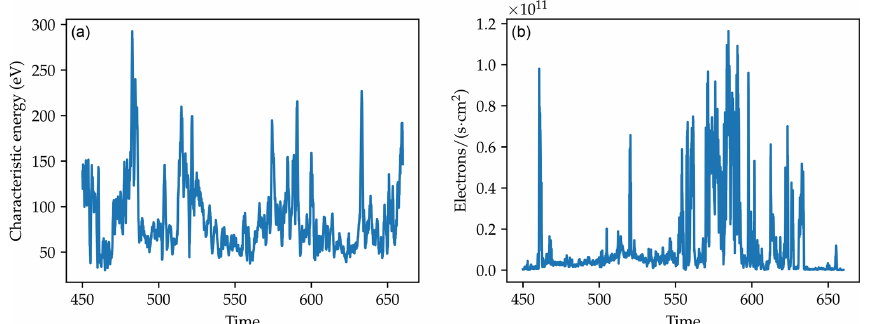
Figure 4. EPLAS characteristic energies (a) and electron flux (b) for the part of the flight where the rocket was in the cusp. The x axis is in flight time with 450s corresponding to 07:41:30UTC and 650s to 07:44:50UTC. For a more detailed data set, see Kenward